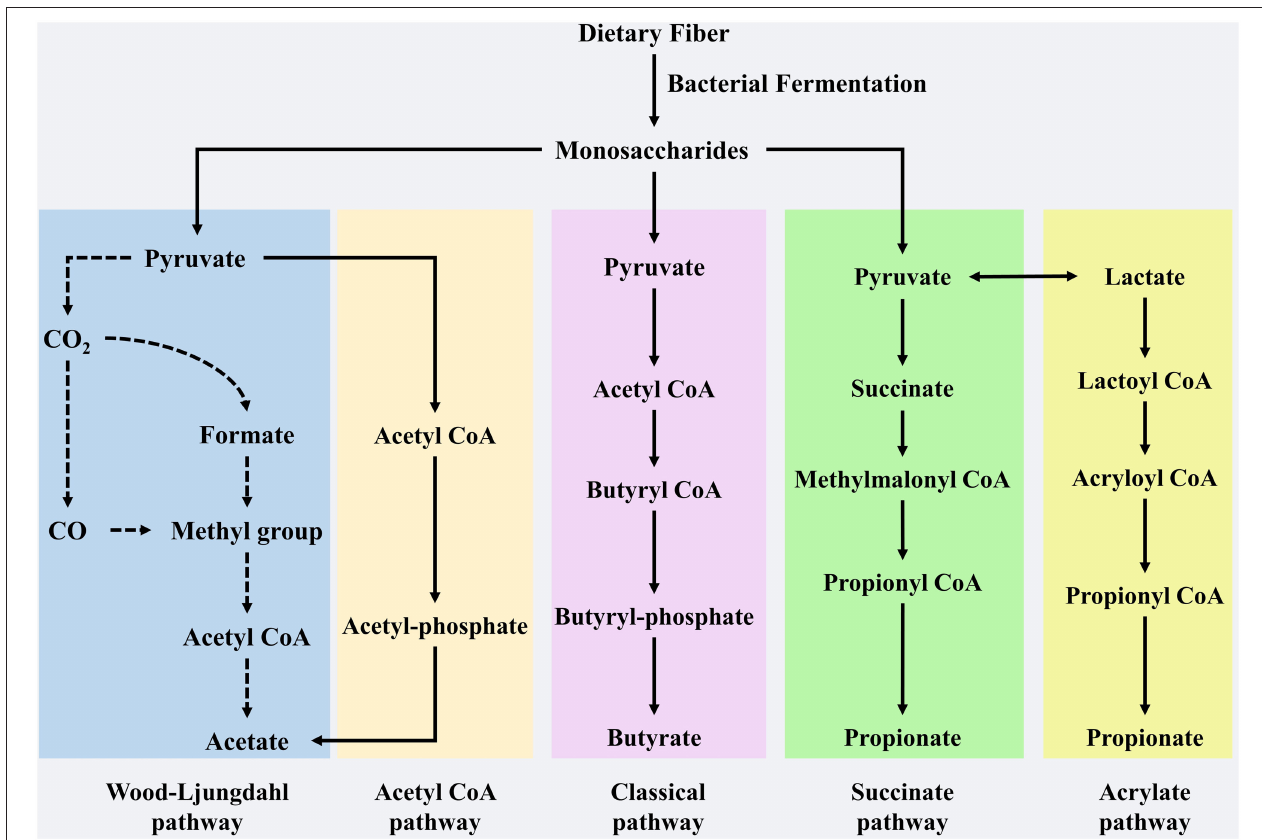
FIGURE 1 | The synthesis pathway of SCFAs. Acetate, propionate and butyrate are main SCFAs produced by dietary fibers of microbial fermentation in gut. Production of acetate involves in pyruvate by Acetyl-CoA and Wood-Ljungdahl pathway. Butyrate is synthesized from Acetyl CoA that is subsequently reduced to Butyryl-CoA, which can be converted to butyrate by so-called classical pathway via Butyryl-phosphate. Propionate can be formed from succinate that is converted to methylmalonyl-CoA by succinate pathway. Furthermore, as a precursor lactate also participate the synthesis of propionate by acrylate